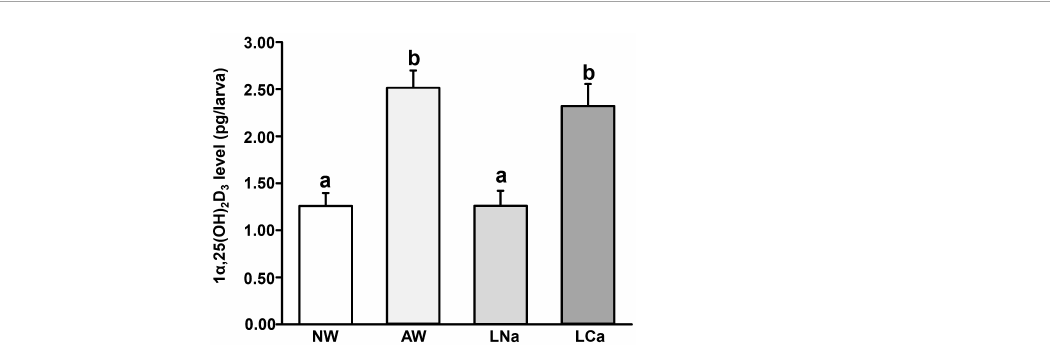
FIGURE 1 Effects of normal freshwater (NW, 0.5 mM [Na + ], 0.2 mM [Ca 2+ ], pH 7.0), acidic NW (AW, 0.5 mM [Na + ], 0.2 mM [Ca 2+ ], pH 4.0), low Na + NW (LNa, 0.05 mM [Na + ], 0.2 mM [Ca 2+ ], pH 7.0), and low Ca 2+ NW (LCa, 0.5 mM [Na + ], 0.02 mM [Ca 2+ ], pH 7.0) on whole body 1 a , 25-dihydroxytamin D 3 (1 a ,25(OH) fi sh larvae. Different letters indicate a signi fi cant difference ( p <0.05), as determined using one-way ANOVA 2 D 3 ) level in 3 days post fertilization (dpf) zebra followed by Tukey ’ s multiple-comparison test. Values are the mean ± SEM ( n